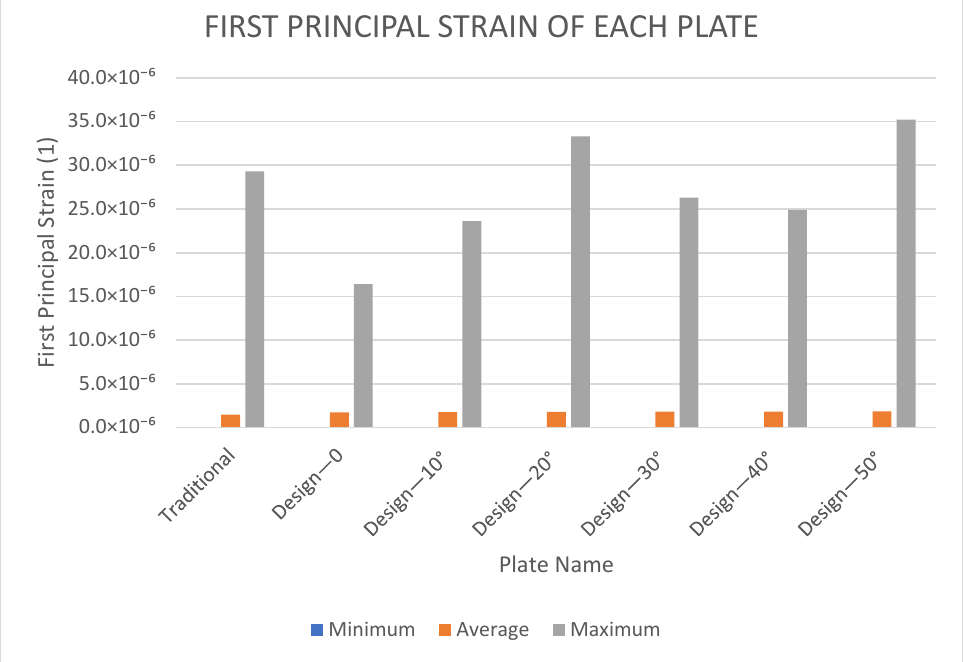
Figure 29. First principal strain (1) of each plate.